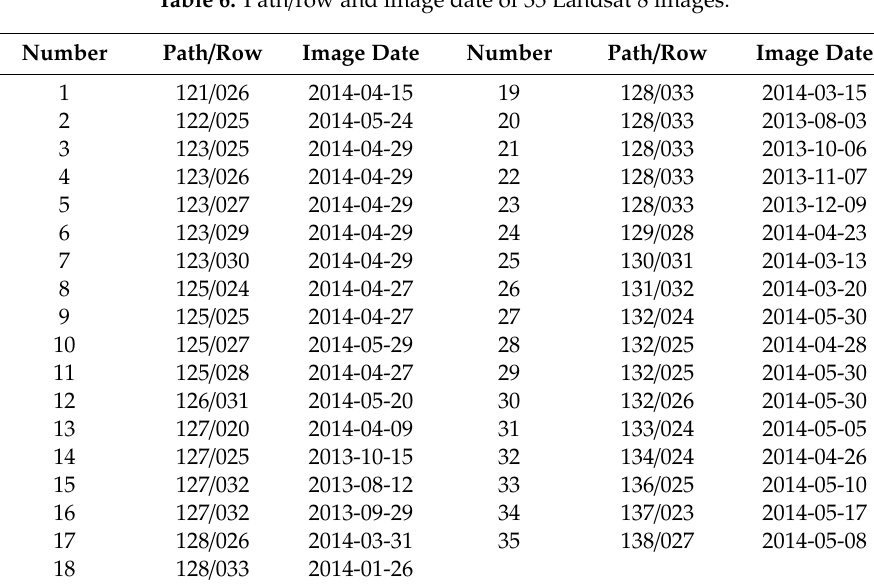
Figure 11. Spatial distribution of 35 Landsat 8 OLI/TIRS images for NDVI verification. Table 6. Path / row and image date of 35 Landsat 8